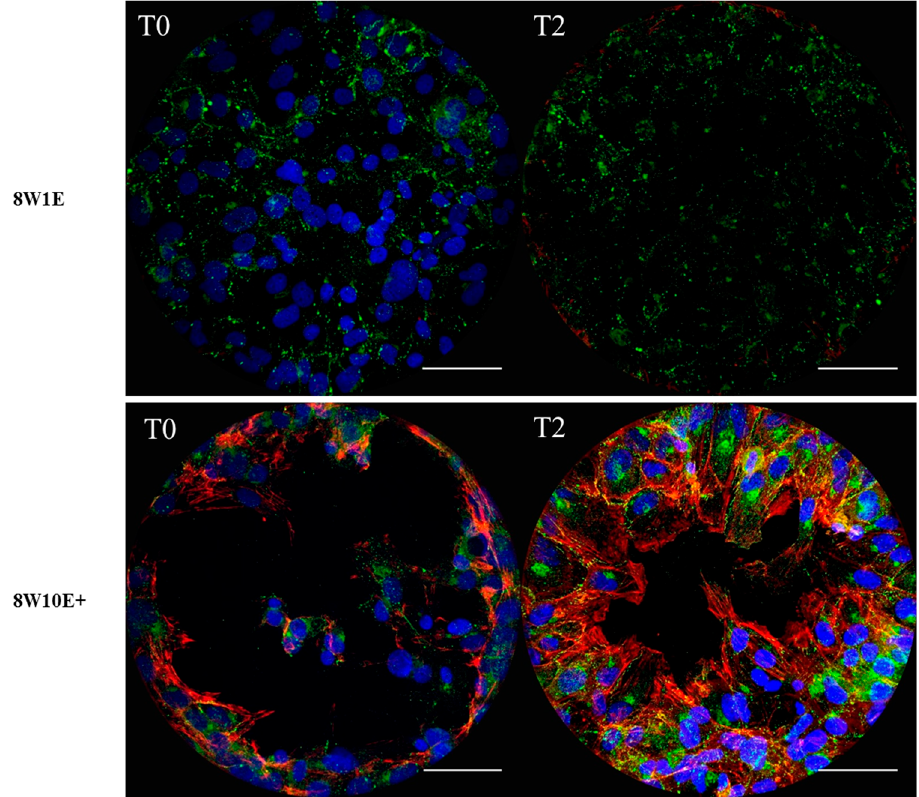
Figure 3. Differences in the wounding pattern between the 8W1E and 8W10E+ arrays. Representative images of the average degree of coverage from three independent experiments are shown. Images are a Z-stack composition between 0.4–0.8 µm at 0 h and 2 h post-wounding on different electrodes. The hCMVECs are labelled for Cx43 using rabbit polyclonal α Cx43 antibody, visualized by goat α -rabbit Alexa Fluor 488 (green) at 40× magnification on the LSM 710 inverted confocal microscope. Actin filaments are stained with ActinRed 555 ReadyProbes Reagent (red). Nuclei are counterstained with Hoechst (blue). The hCMVECs were seeded at a density of 60,000 cells/cm 2 . A wounding current of 3000 uA at 60 kHz was delivered for 30 s to selected wells on the 8W1E array, and a wounding current of 5000 uA at 60 kHz was delivered for 60 s to selected wells on the 8W10E+ array. Scale bar = 50 µm.